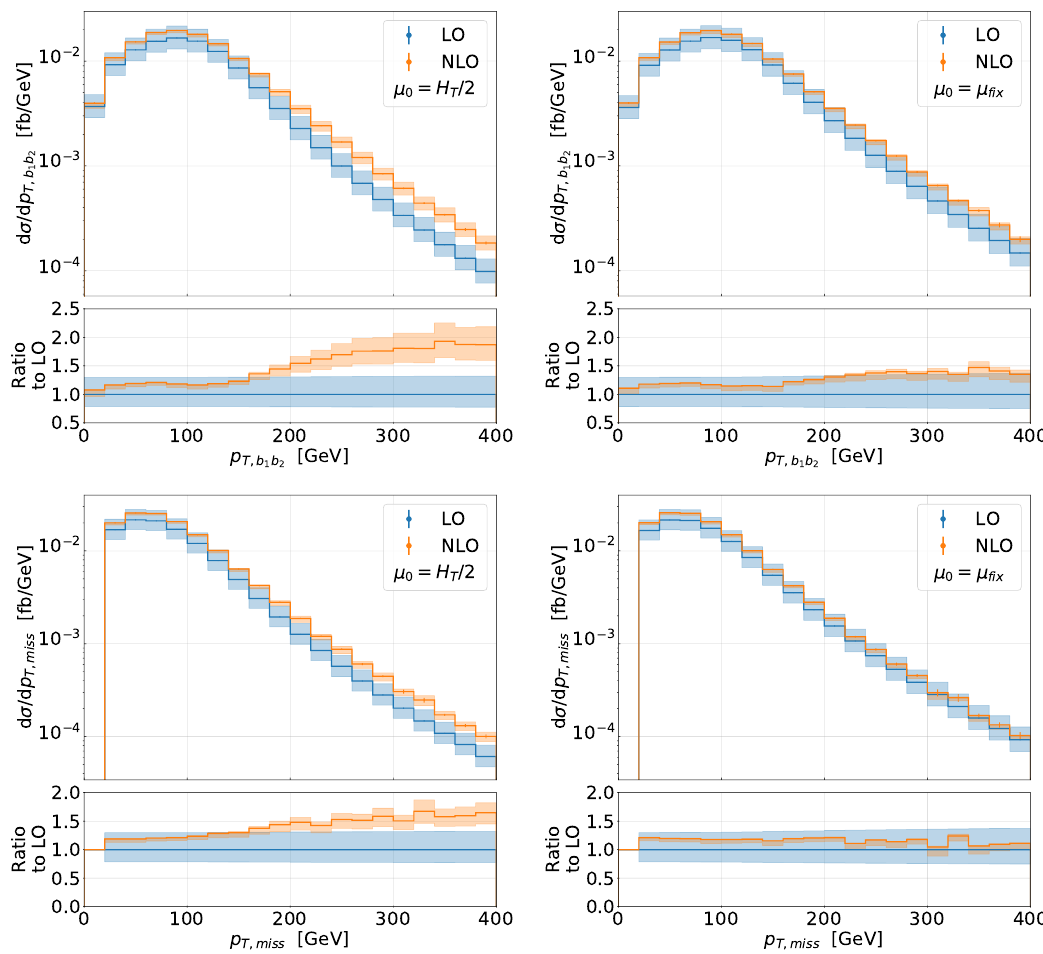
Figure 9 . Differential distributions at LO and NLO QCD with the corresponding uncertainty bands for the observables p T,b and p T, miss for the pp → e + ν e µ − ¯ ν µ b ¯ b H process at the LHC with √ 1 b 2 s = 13 TeV. Results are presented for µ 0 = H T / 2 and µ 0 = µ fix . The NNPDF3.1 PDF set is employed. Also given are Monte Carlo integration errors. The lower panels display the differential K